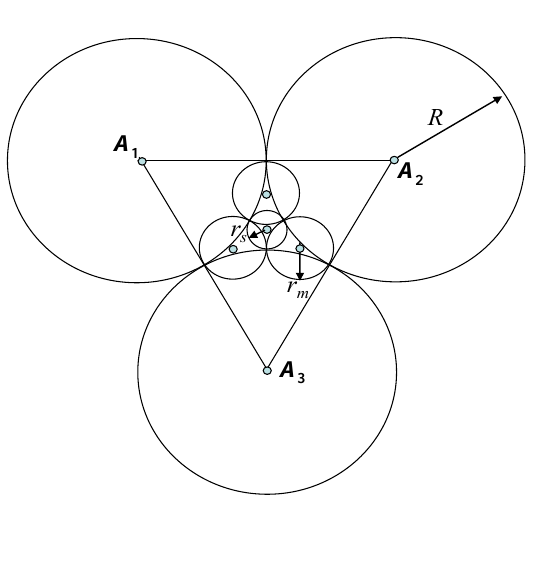
Figure 4. Model III